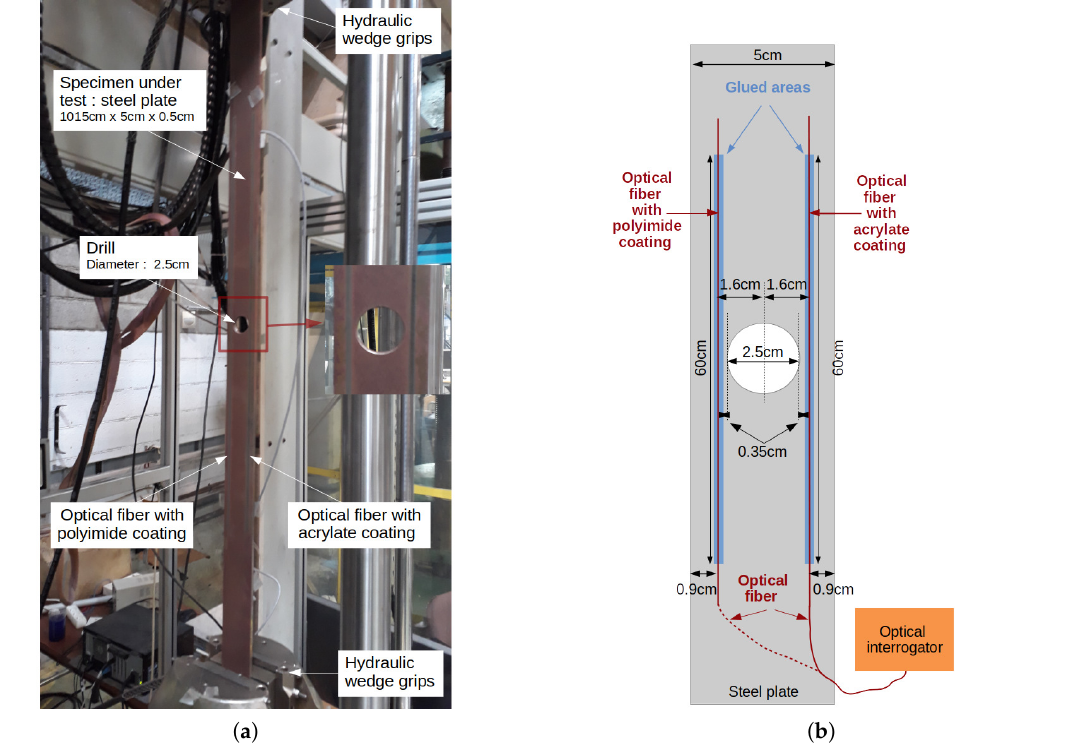
Figure 13. Experiment description of non-uniform strain field measurements. ( a ) Photography of the instrumented specimen under tensile test. ( b ) Schematic presentation of the specimen instrumentation.